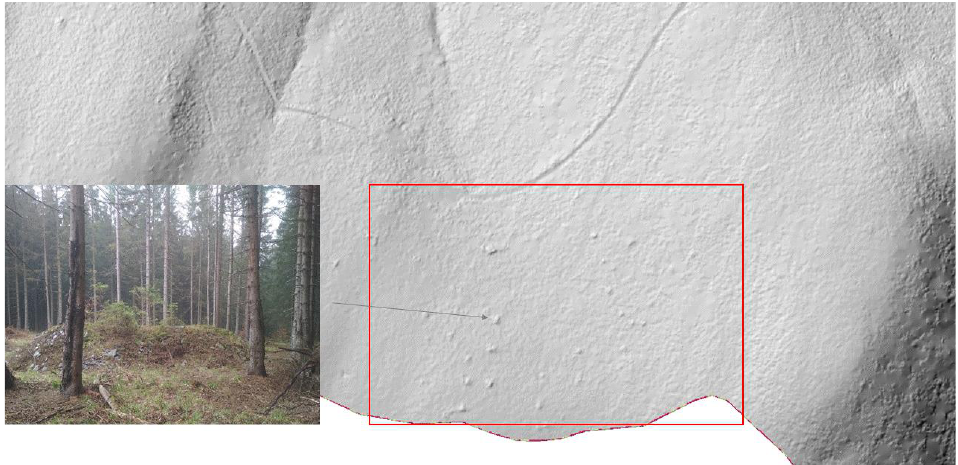
Figure 8. Stone pile — demonstration in the field and in the DRM, elements can be observed in the red frame; ZABAGED® Height chart DMR G5 (ags.cuzk.cz); adjusted.